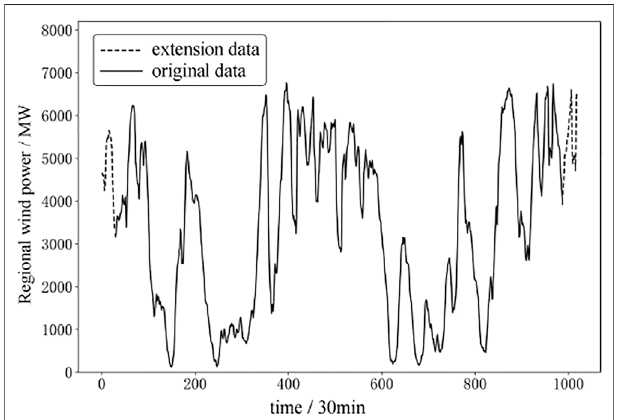
FIGURE 1 | Diagram of the data extension